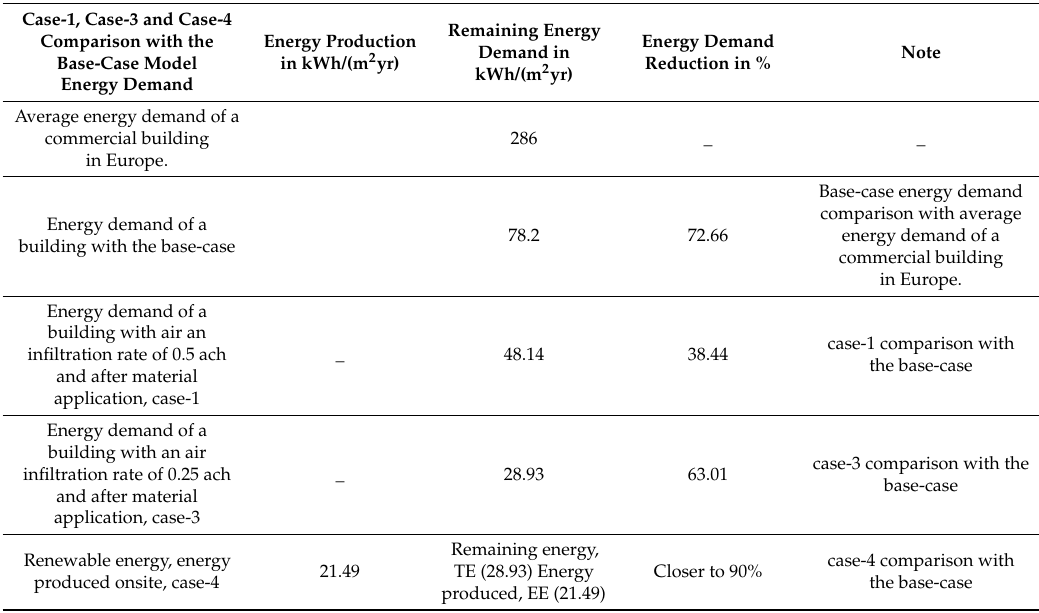
Table 10. Reduction in Energy demand after comparing case-1, case-3 and case-4 with the base-case energy